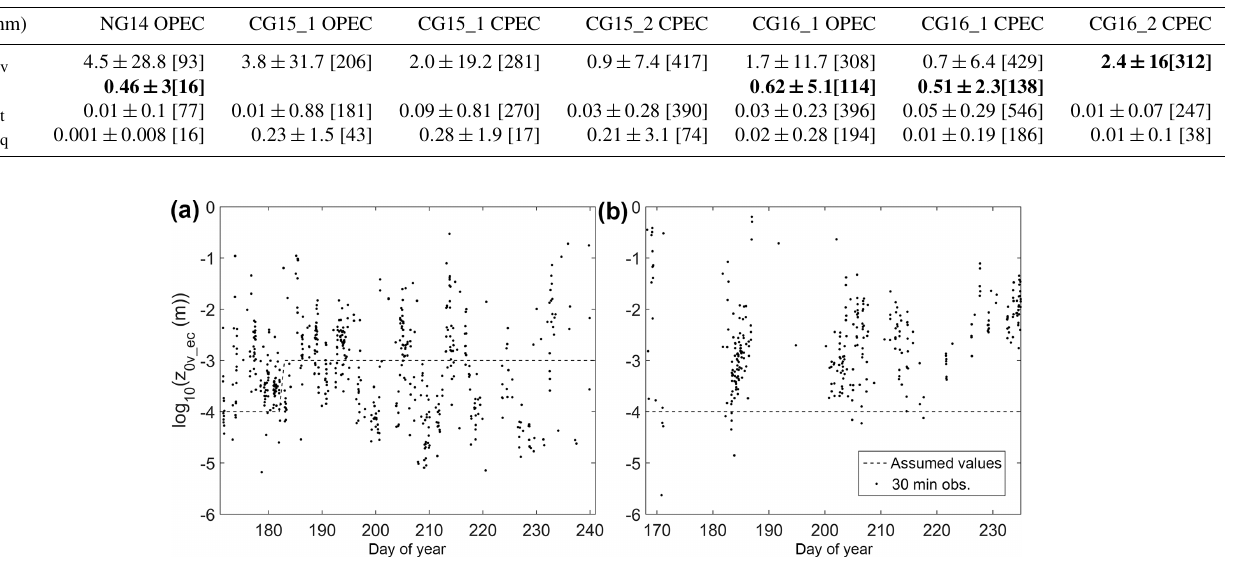
Figure 6. 30min z 0v_ec values as observed at (a) CG16-1 and (b) CG16-2. The dashed line represents the commonly assumed z 0v values of 1 and 0.1mm for ice and snow. At CG16-1, the surface transitioned to bare ice on day of year (DOY)